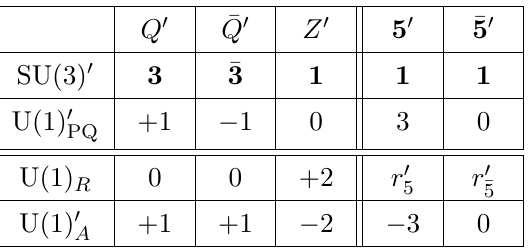
symmetry corresponds PQ